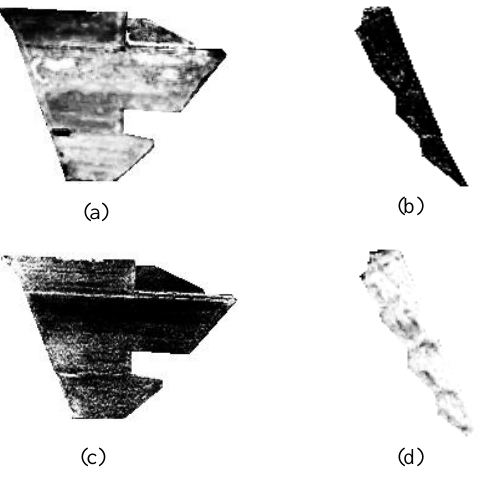
Figure 5. Certainty of pixels in texture domain to class A ((a) and (b)) and class B ((c) and (d)). Values ranges from uncertainty (0, black) to certain (1, white)